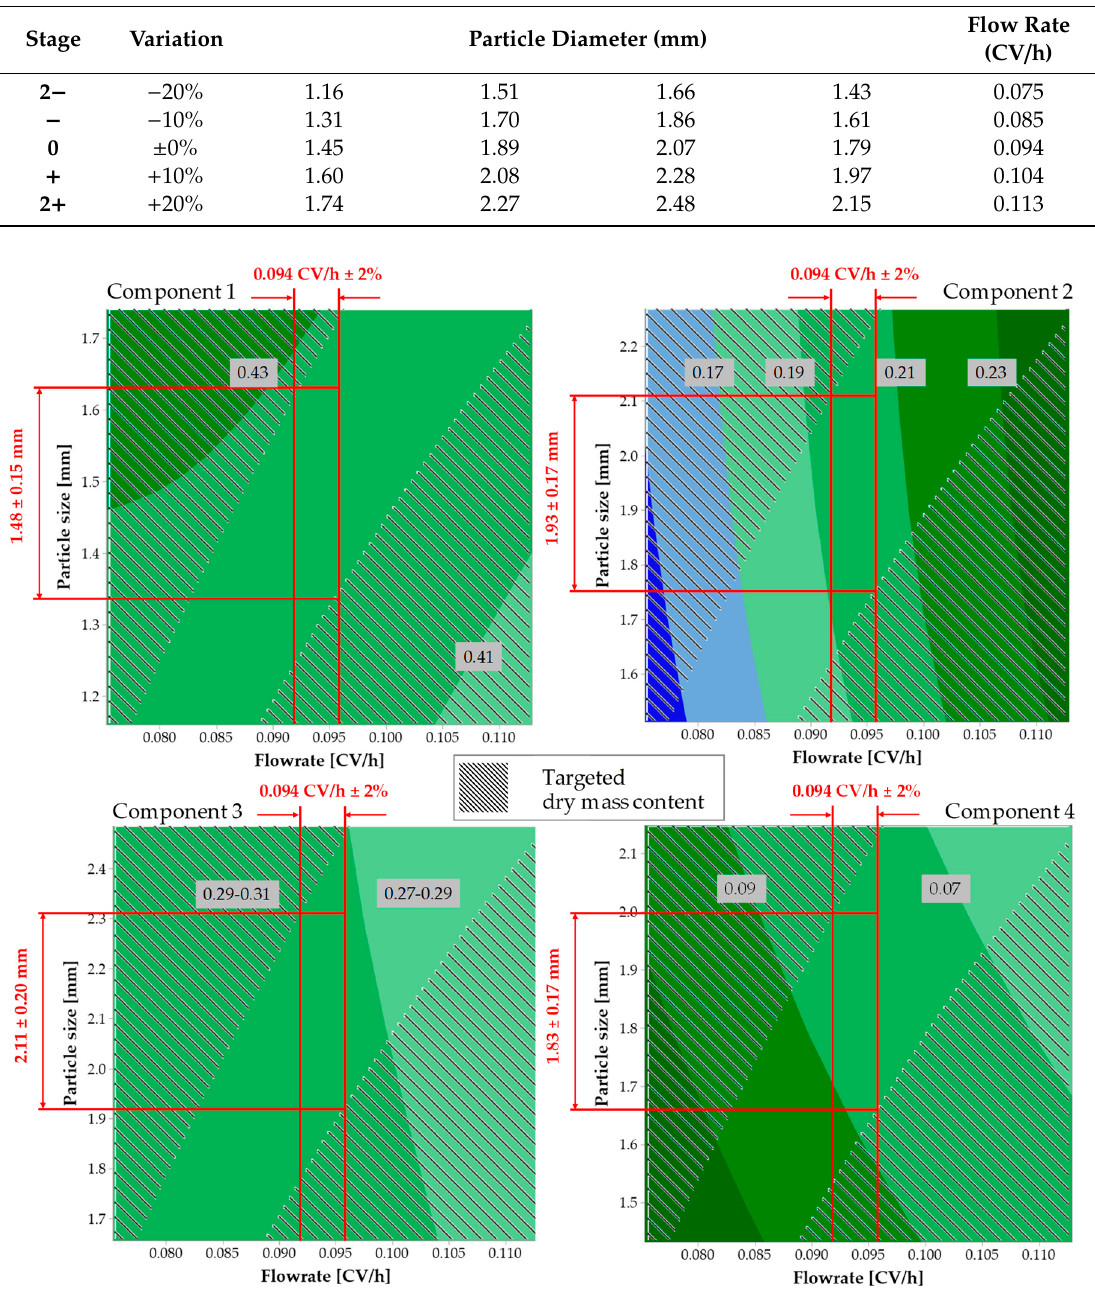
Figure 16. Design spaces for component 1–4 for varying flow rates and particle sizes.